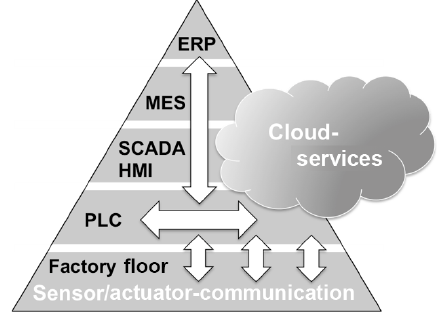
Figure 2. New standards and technologies enable horizontal and vertical communication systems integration and to break-up the classical automation pyramid, according to VDI/VDE (2013); Jeschke et al.